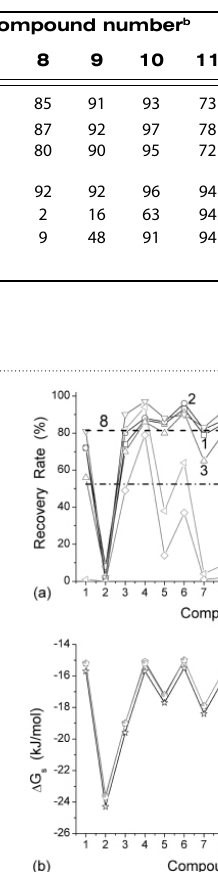
Table 3. Recovery rates R and R ava [%] of amphetamine derivatives on studied adsorbents. 1